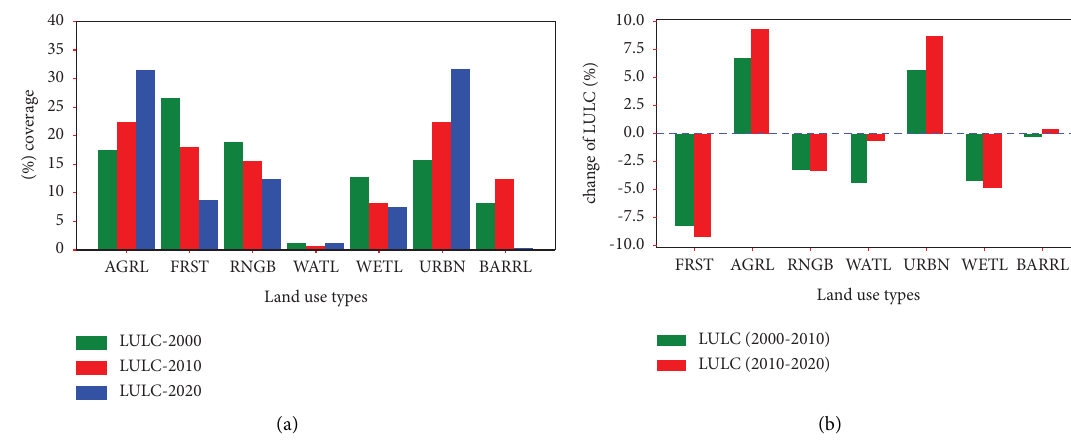
Figure 6: (a) Annual coverage in percent and (b) annual change over time in